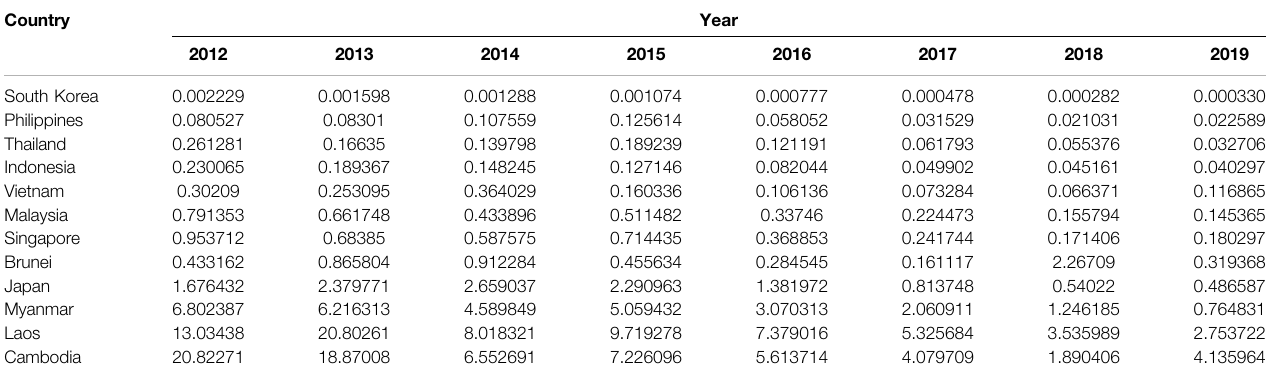
TABLE 5 | Time trend of the export ef fi ciency values of China ’ s exports to ASEAN plus Japan and South Korea.